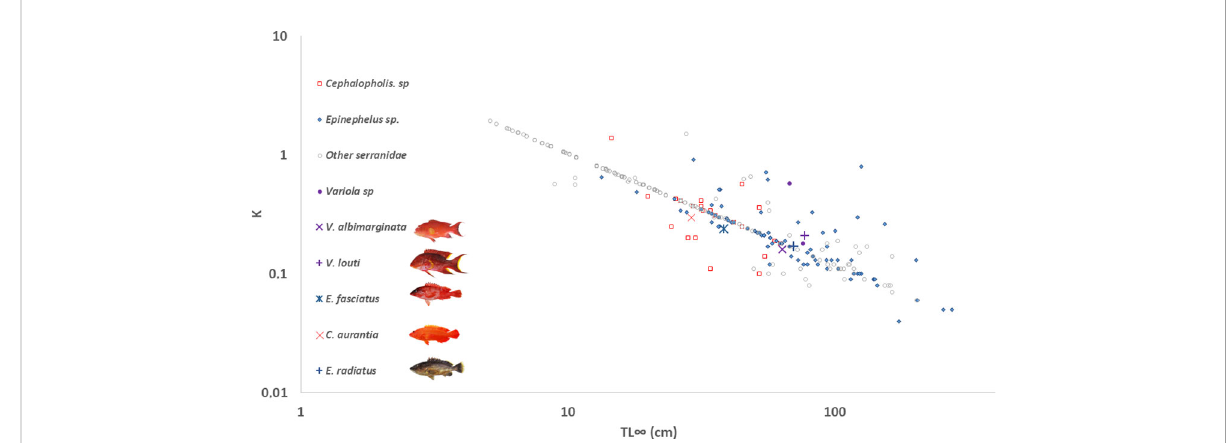
FIGURE 5 Auximetric plot of fi ve grouper species from La Re ́ union Island relative to other species of the Serranidae family (Source Fishbase, n=321 species, only the Total Lengths were used). The auximetric plane is the plane de fi ned by two logarithmic axes representing the von Bertalanffy rate coef fi cient K versus asymptotic total length TL ∞ , where a population characterized by a set of von Bertalanffy growth parameters ( TL ∞ ), is represented by a